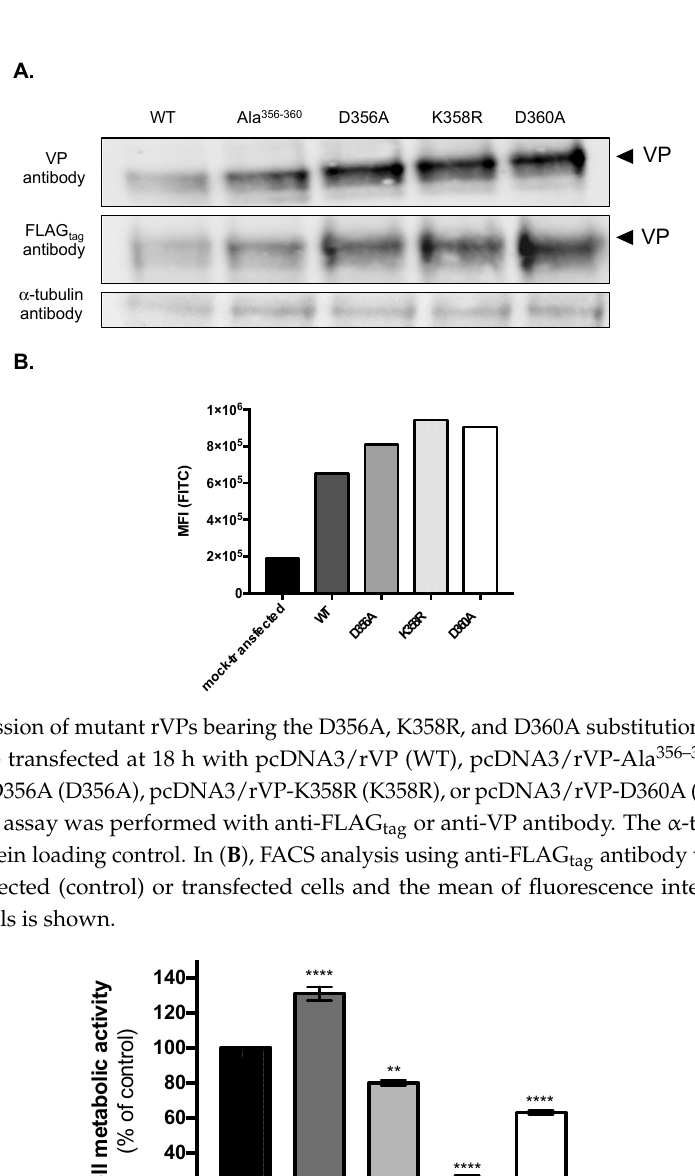
Figure 3. Metabolic activity of cells expressing rVP mutants. A549 cells were transfected at 18 h with pcDNA3/rVP (WT), pcDNA3/rVP-D356A (D356A), pcDNA3/rVP-K358R (K358R), or pcDNA3/rVP-D360A (D360A) and cell metabolic activity was measured 24 h later (42 h post-transfection) using a MTT assay. As a plasmid control, cells were transfected with pcDNA3/ RenLUC (control). Viability was expressed as the percentage of cell metabolic activity in assay relative to that in control. Results were expressed as the mean ( ± SEM) from three independent